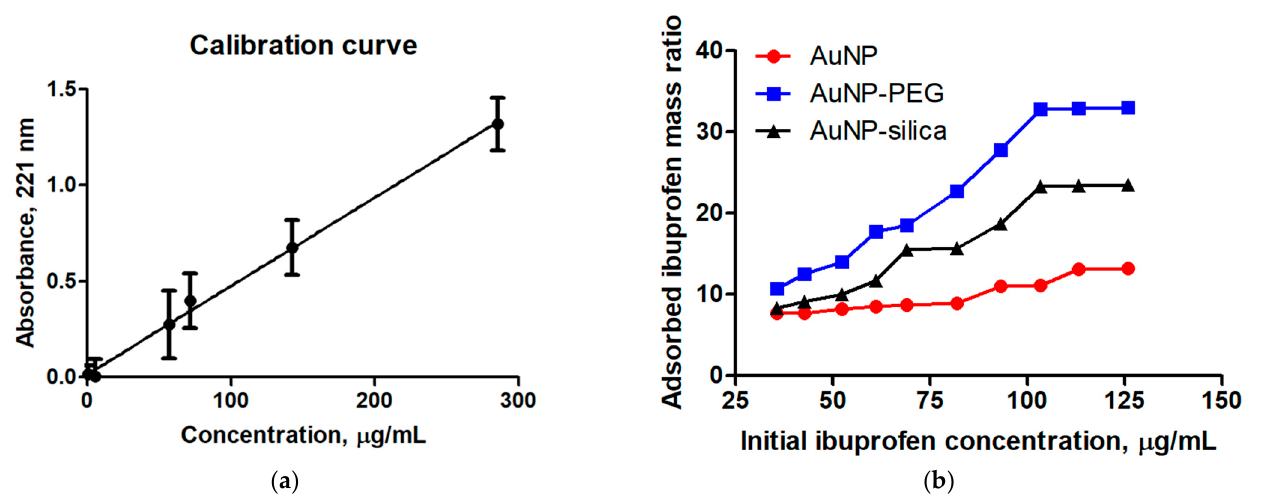
Figure 5. Calibration curve for ibuprofen obtained with triplicate measurements ( a ). In ( b ), the drug loading graphs can be seen, where it is observed that the uncoated AuNPs do not exhibit efficient drug loading, while coating with silica increases the drug loading efficiency, but the PEG coating achieves the best drug loading. The PEG coating achieves a mass loading of 33%, while the silica achieves around 25% when a concentration of 100 micrograms per milliliter of the drug is used, and the uncoated AuNPs achieve around 10%.